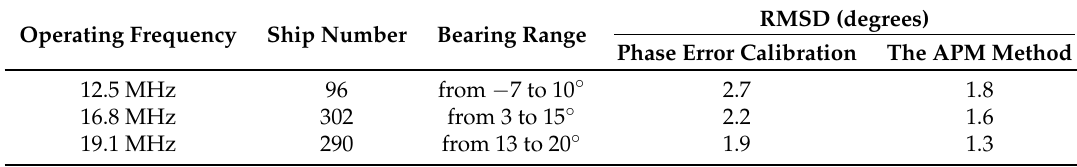
Table 3. Ship DOA estimation in the radar bearing range where phase distortion is